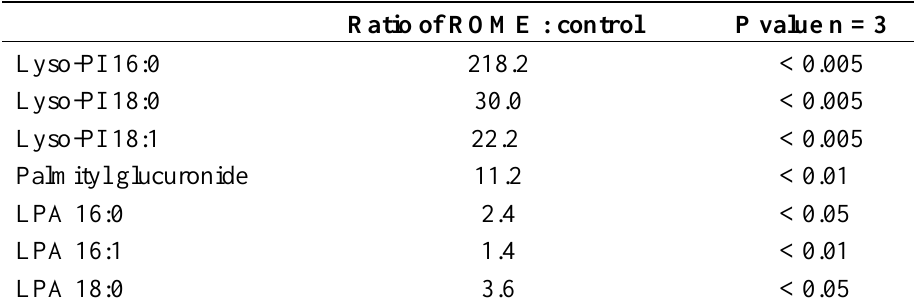
Table 4. Effect of ROME (10 μM, 24 h) on lyso-PI and LPA species in androgen-sensitive LNCaP cells. Results are expressed as the ratio ROME:control for each metabolite. P values are presented for ROME vs. control (experimental results from n = 3 cell samples for each